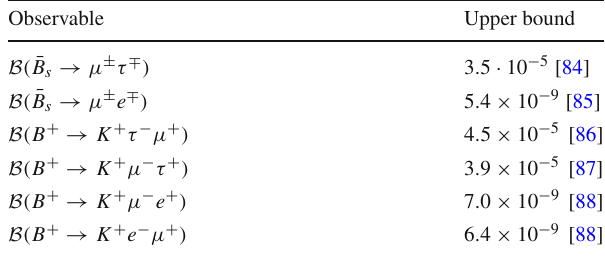
. We give the values in units of 10 − 21 GeV − 1 . This factor is compensated by the size of the decay FB